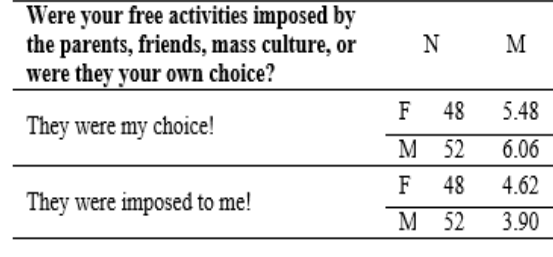
Table 5. Gender differences according to the de-